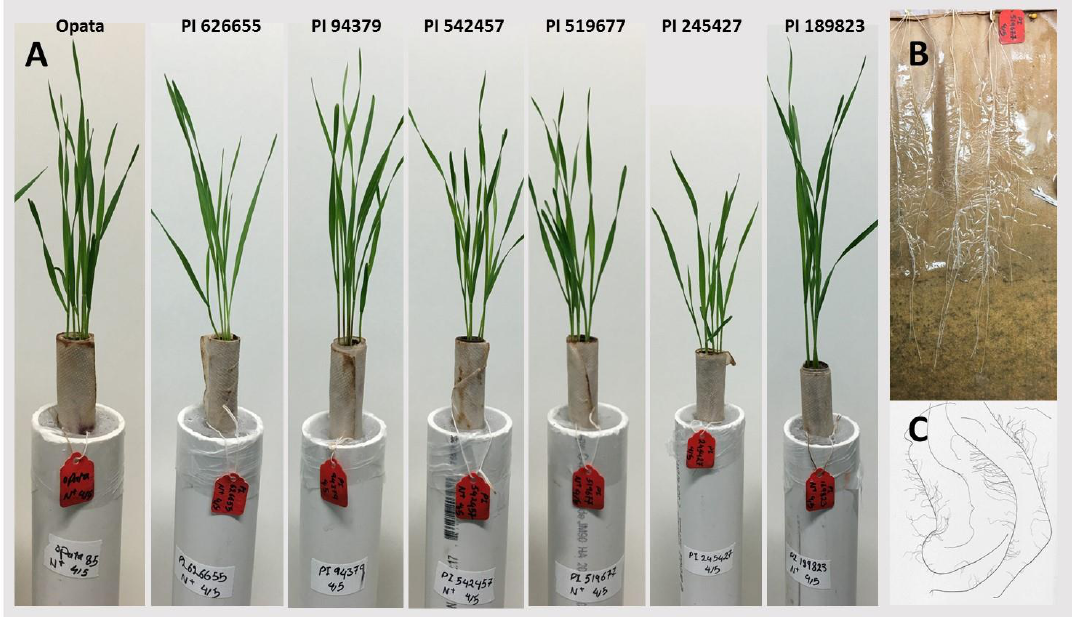
Figure 1. Seedlings were grown for two weeks in paper roll-supported hydroponic solutions containing low or high N nutrient solutions. Representative hydroponic tubes of each line ( A ), unfolded paper roll after two weeks that shows seminal root growth and branching ( B ), and the image taken on tray by the WinRhizo software ( C ) are demonstrated.